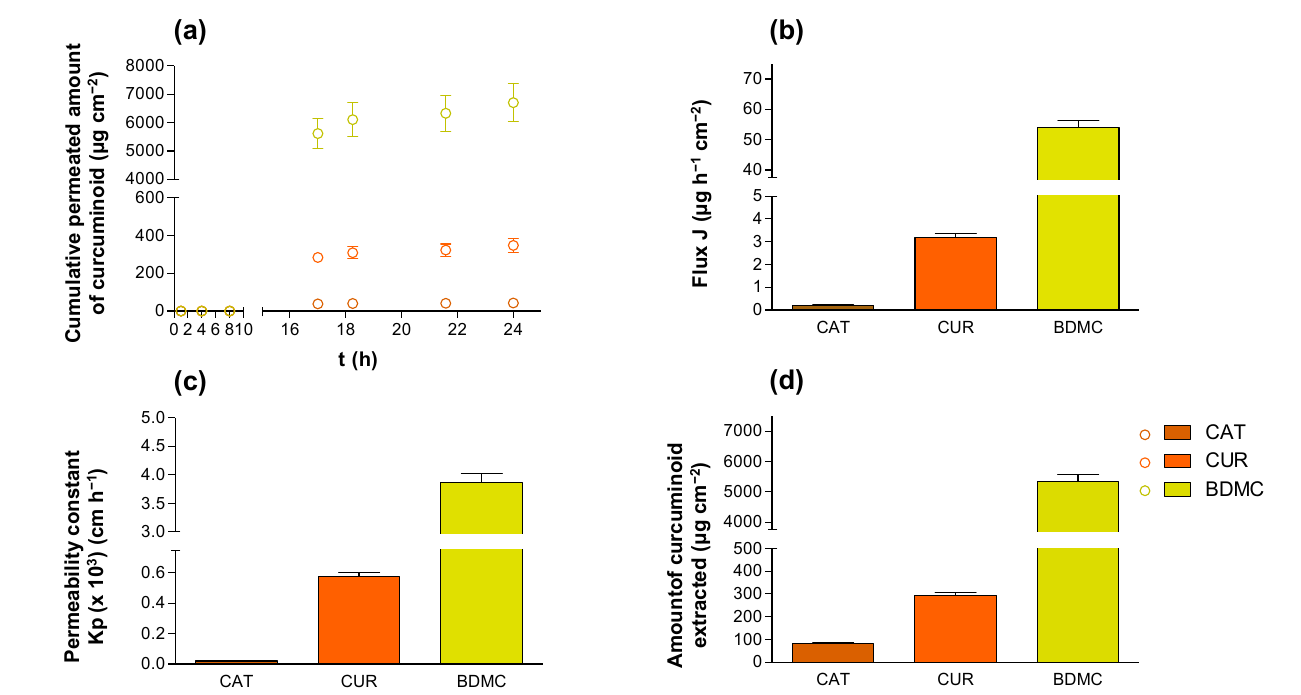
Figure 4. Ex vivo permeation of the curcuminoids through human skin: ( a ) permeation profile of the curcuminoids, ( b ) flux at the steady state (J), ( c ) permeability constant (Kp), ( d ) amount of curcuminoids extracted from the skin after 24-h permeation. Results represent the mean ± SD ( n = 5). Consequently, the permeation fluxes (J) obtained for BDMC, CUR and CAT